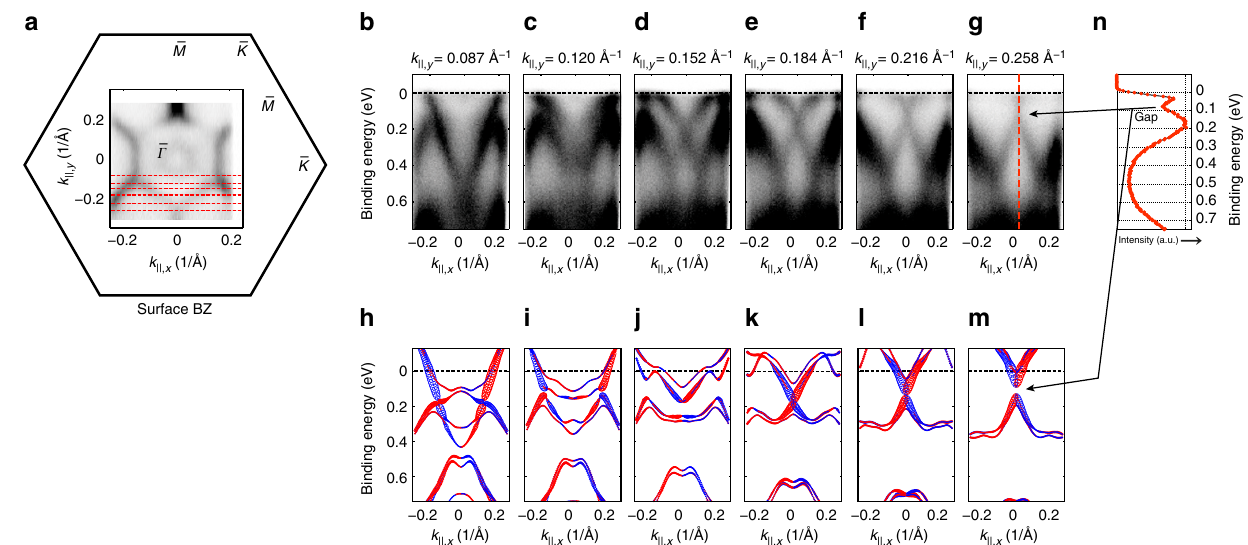
Figure 6 | Electronic structure of Bi 1 Te 1 along non-high-symmetry lines revealing TCI surface states. ( a ) Fermi surface k ||, x versus k ||, y map of a 45nm in situ transferred film of Bi 1 Te 1 obtained with h n ¼ 8.4eV. Red dashed lines mark trajectories along which E B ( k ||, x ) spectra in b – g were recorded. Sketch of the surface Brillouin zone is marked for orientation. ( b – g ) Corresponding experimental spectra as well as spin-polarized DFTcalculations ( h – m ) of a 24QL slab of Bi 1 Te 1 with 1QL-terminated surface at ( b , h ) k ||, y ¼ 0.087Å (cid:2) 1 , ( c , i ) 0.120Å (cid:2) 1 , ( d , j ) 0.152Å (cid:2) 1 , ( e , k ) 0.184Å (cid:2) 1 , ( f , l ) 0.216Å (cid:2) 1 and ( g , m ) 0.258Å (cid:2) 1 , respectively. ( n ) Energy distribution curve along the red dashed line in g